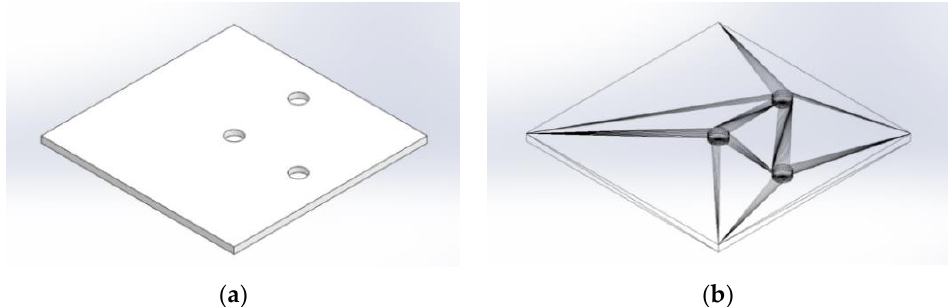
The bottom BPS plate “slice phase” and the finished part with installed magne tic Figure 8. BPS plate bottom view: ( a ) Visualization in SolidWorks; ( b ) SolidWorks mesh model. cups are shown in Figure 9.